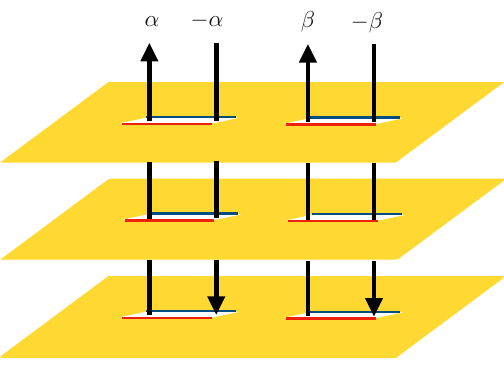
Figure 1 . Representation of the n -sheeted Riemann surface Σ n for n = 3 . The red edge of each cut is identified with the blue edge of the corresponding cut in the lower copy. The calculation of the multi-charged moments in eq. (2.11) requires to insert different magnetic fluxes between the sheets, which we indicate by the arrows. The operator e iαQ A 1 is implemented by the flux insertions α and − α along the left interval, while e iβQ A 2 corresponds to the fluxes β and − β at the right